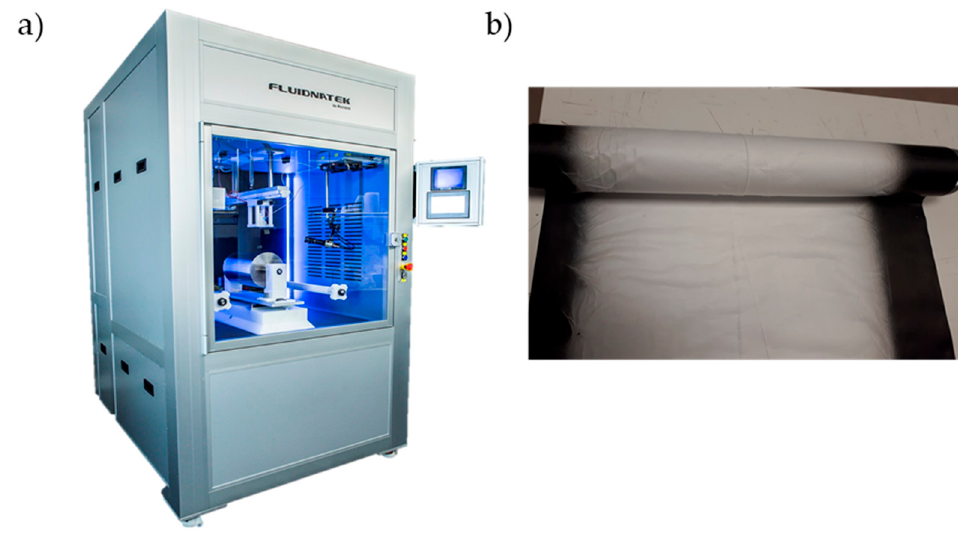
Figure 1. ( a ) Electrospinning equipment Fluidnatek TM LE-500; ( b ) Electrospun pullulan mesh rolled sample.